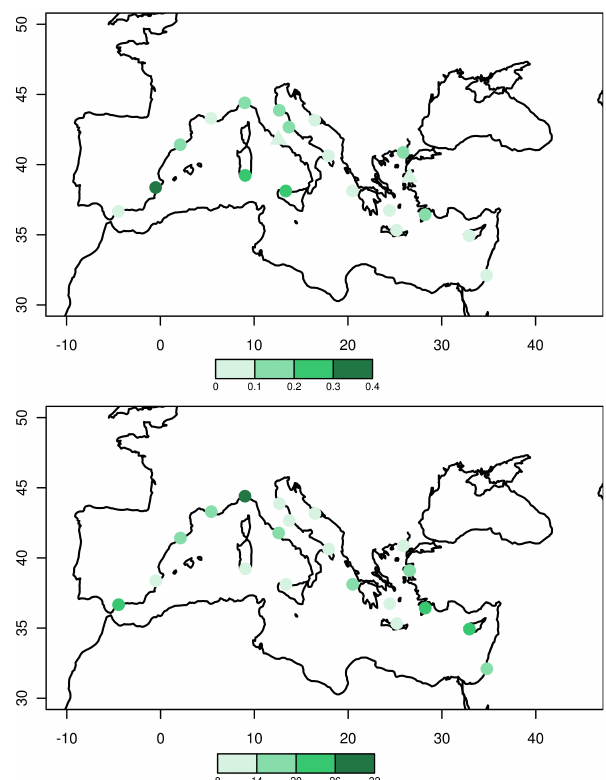
Fig. 1. Geographical position of the 20stations. Colours are as- sociated with the shape (upper panel) and scale (lower panel) pa- rameters of the GPD estimated for each series. In the shape plot, triangles denote a negative